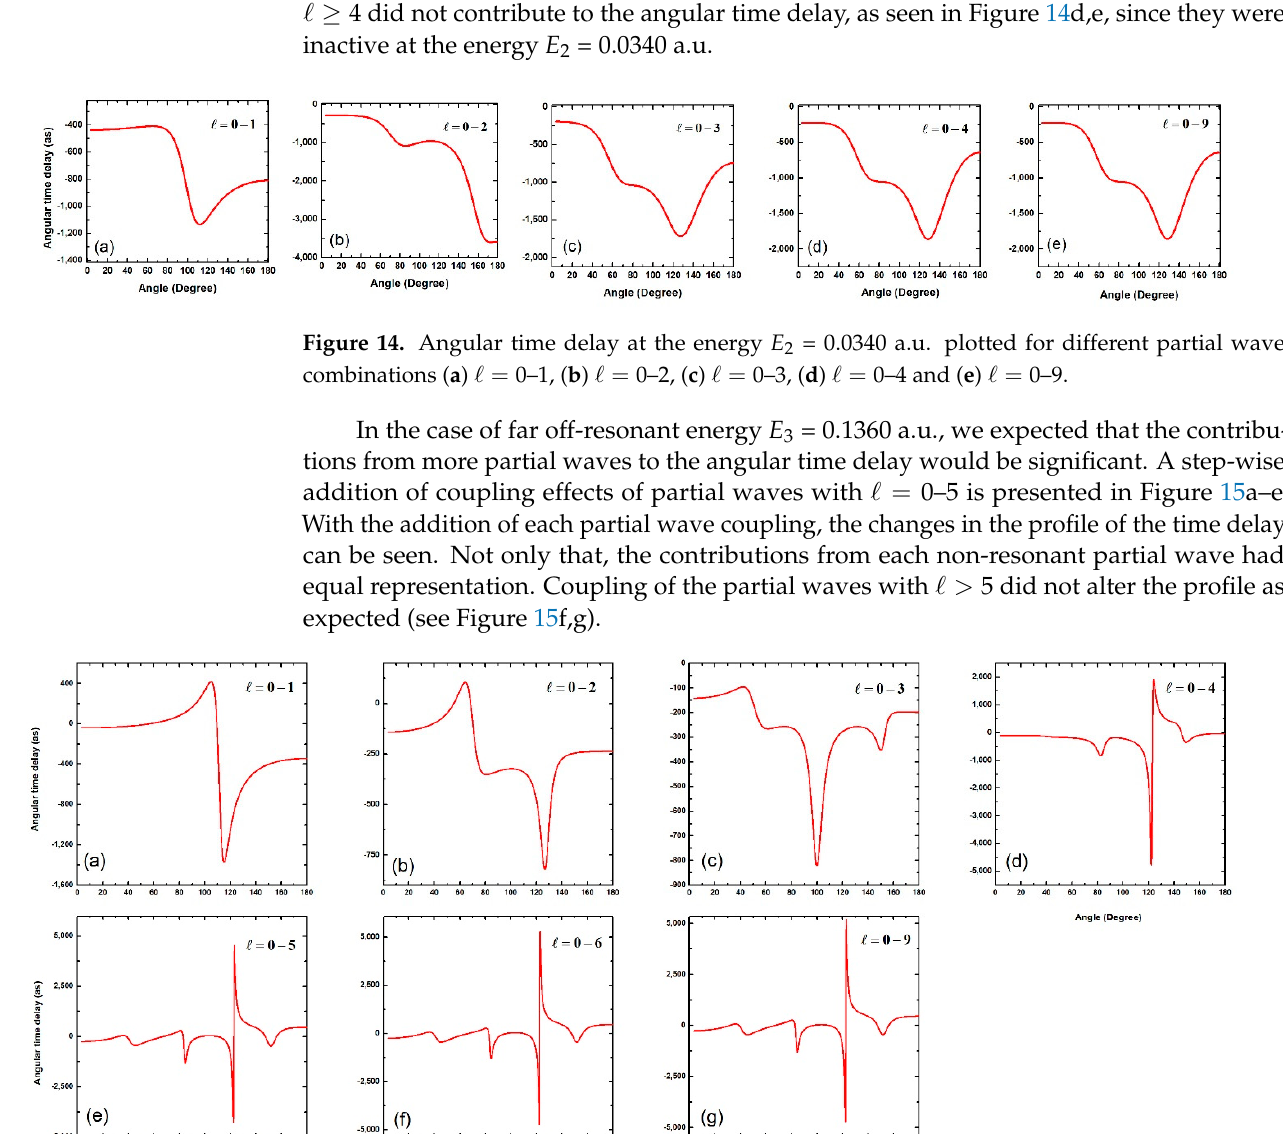
Figure 13. Angular time delay at the energy E 1 = 0.0050 a.u. plotted for different partial wave com- binations ( a )